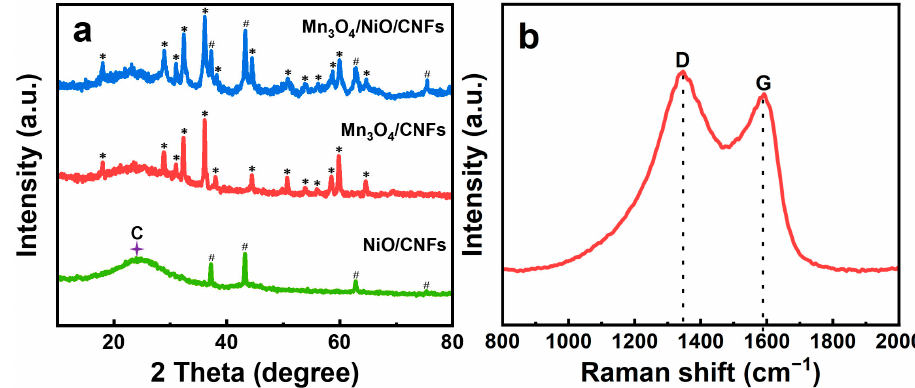
Figure 1. ( a ) XRD patterns of Mn 3 O 4 /CNFs, NiO/CNFs, and Mn 3 O 4 /NiO/CNFs; ( b ) Raman spectrum of Mn 3 O 4 /NiO/CNFs at 800 °C.